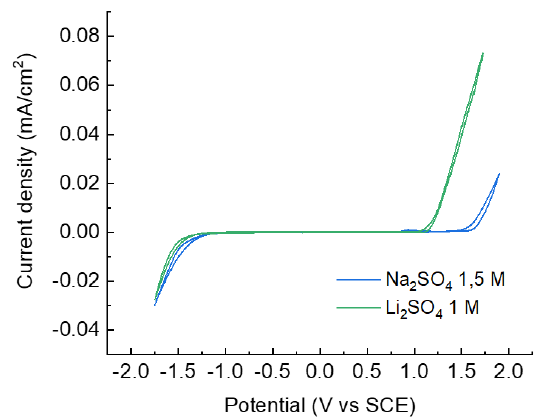
Figure A6. Cyclic voltammetry of different electrolyte solutions at 20 mV/s.